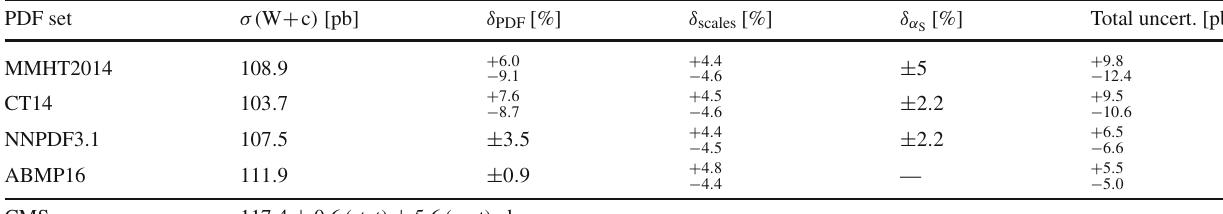
Table 11 Theoretical predictions for σ( W + c ) from mcfm at NLO. The kinematic selection follows the fiducial phase space definition: p (cid:3)